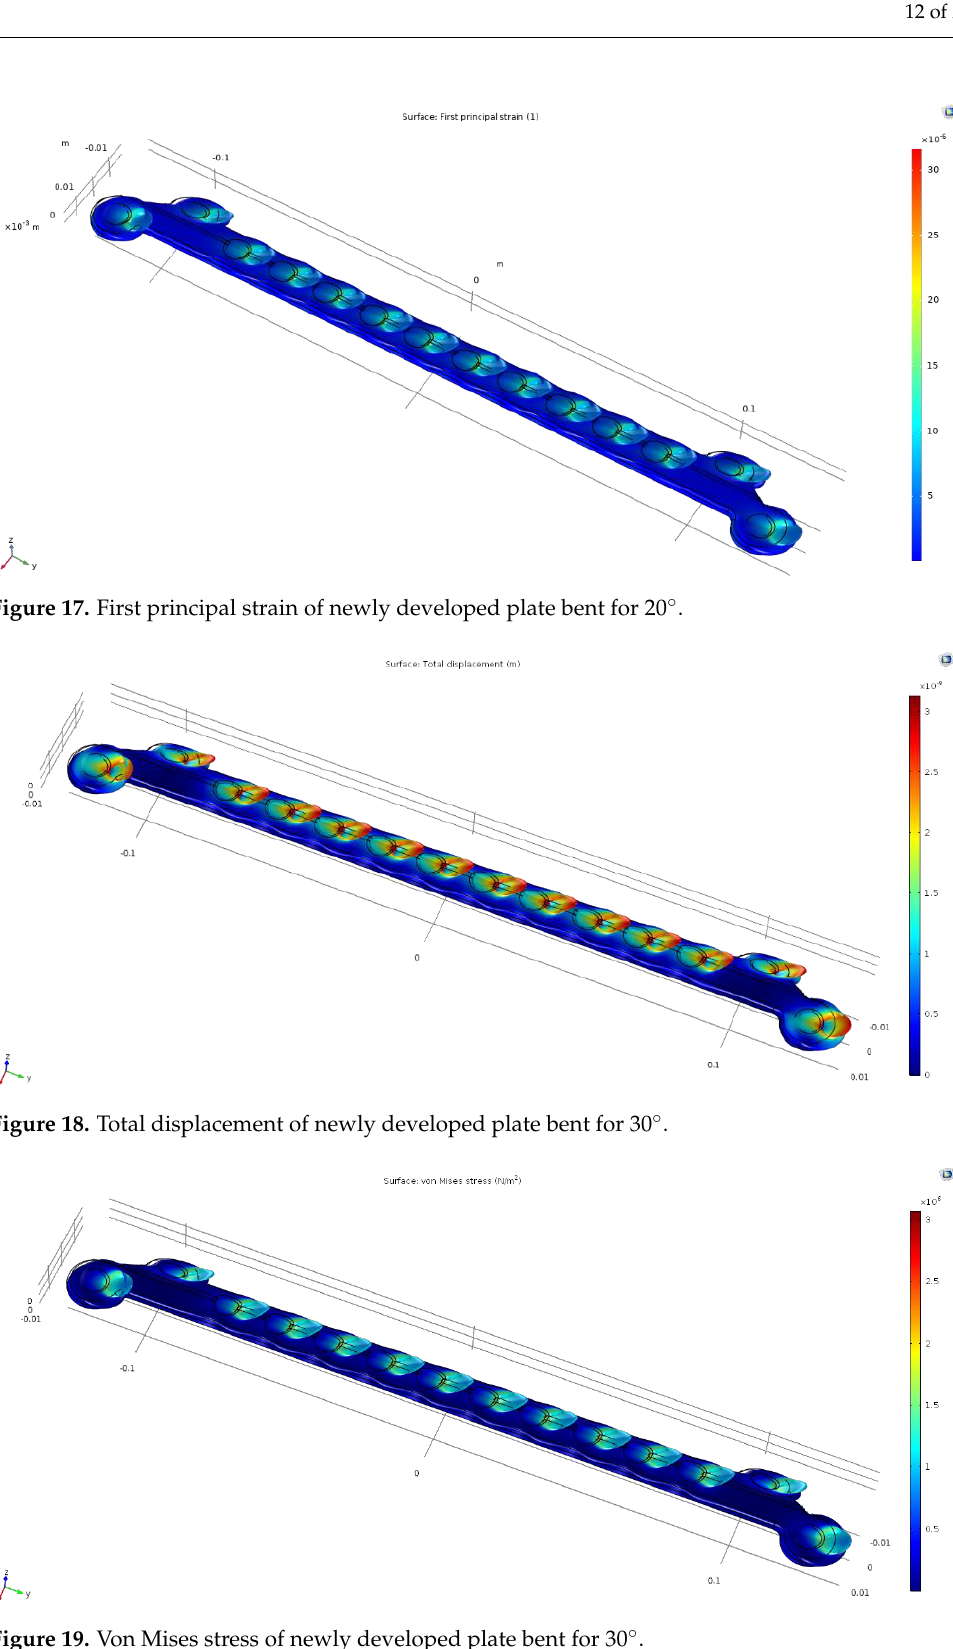
Figure 19. Von Mises stress of newly developed plate bent for 30°.